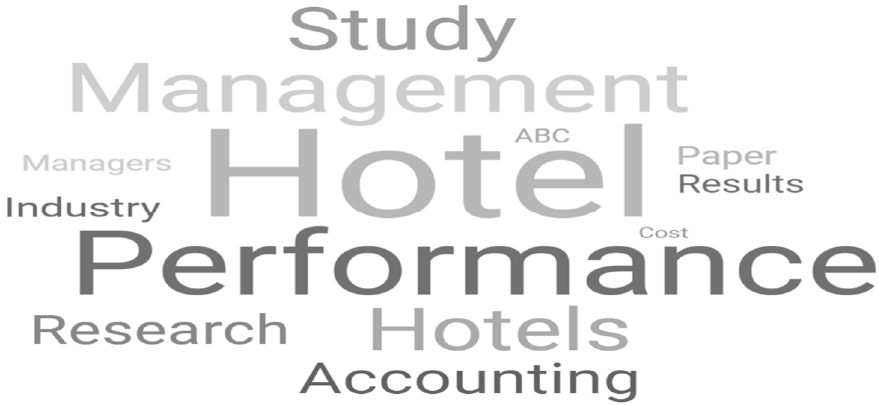
Figure 2. Word cloud of the top ten most frequently used words in abstracts.